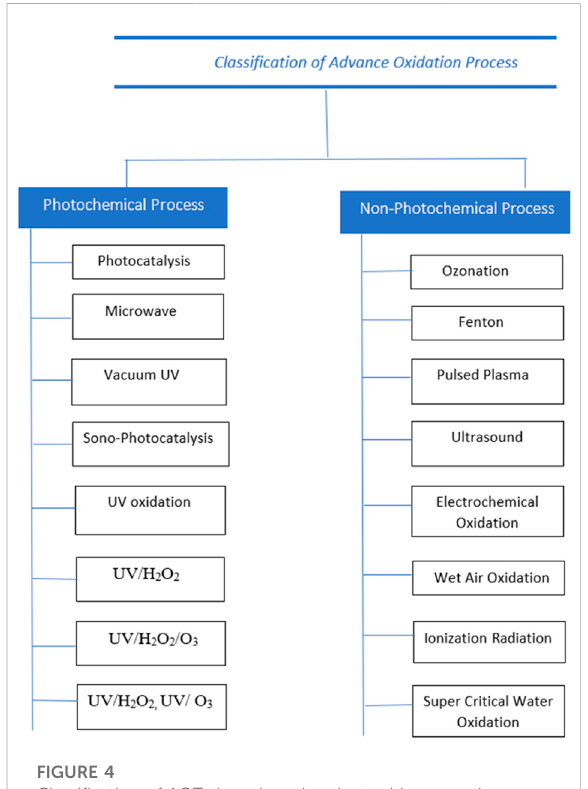
FIGURE 4 Classi fi cation of AOTs based on the photo-driven reaction.